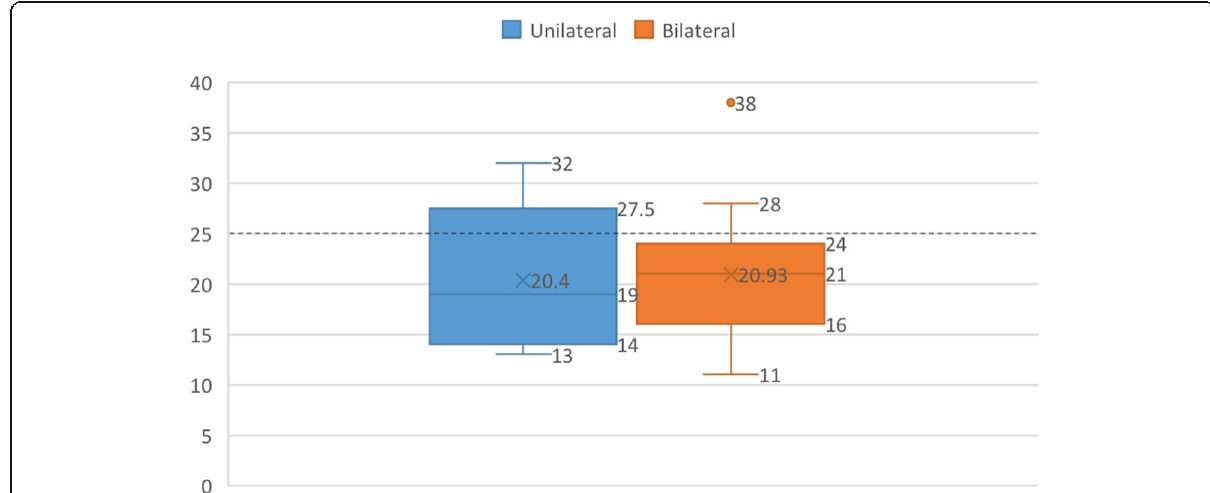
Fig. 8 Box plots of the oral sensory processing section in children with unilateral and bilateral SCP